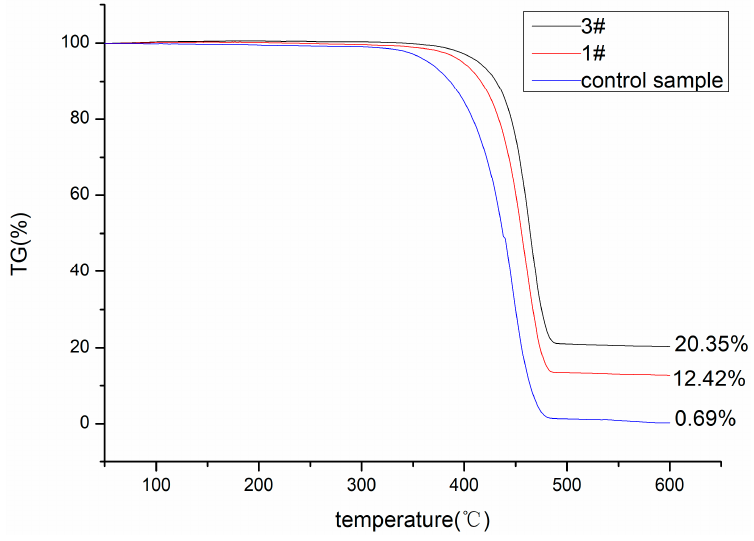
Figure 7. TG curves of control and Ag coated nonwoven polypropylene.